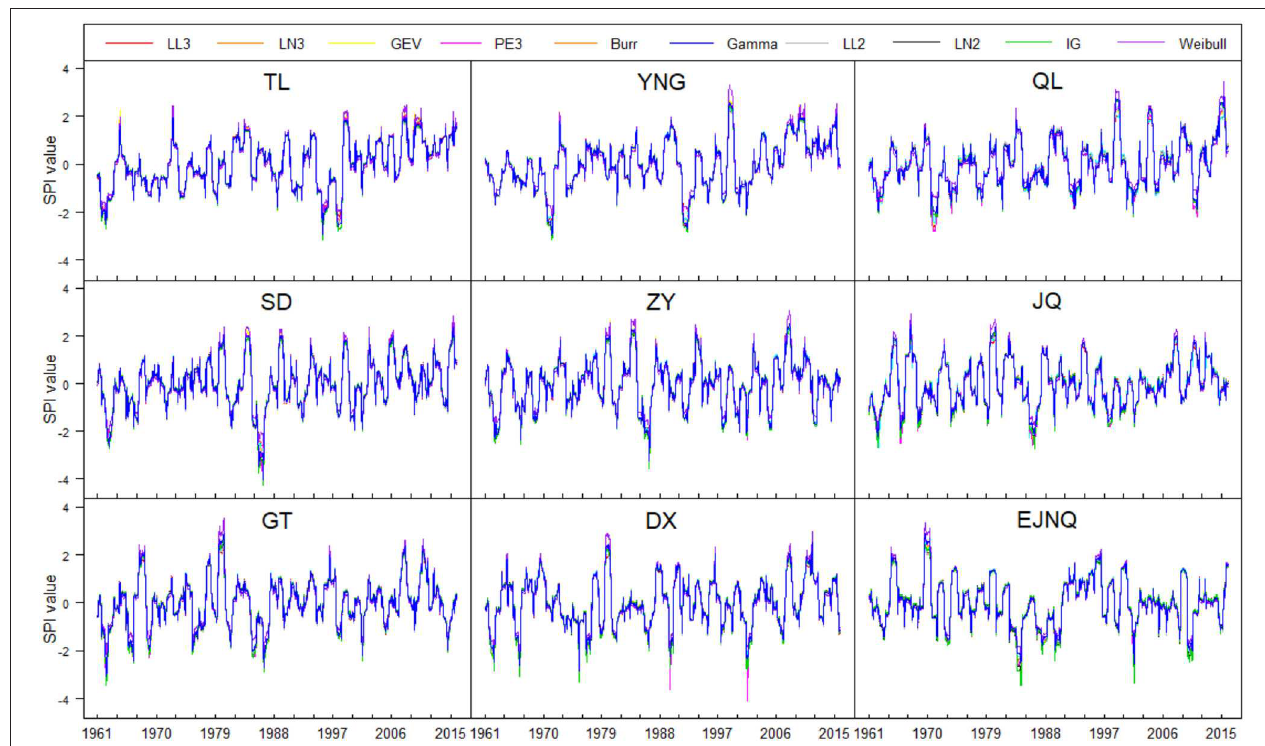
FIGURE 3 | SPI values modeled by different probability distributions (LL3, LL2, LN3, LN2, GEV, PE3, and IG represent the three- and two-parameter log-logistic and log-normal, generalized extreme value, Pearson-III, and inverse Gaussian distributions, respectively; TL, YNG, QL, SD, ZY, JQ, GT, DX, and EJNQ are Tuole, Yeniugou, Qilian, Sandan, Zhangye, Jiuquan, Gaotai, Dingxin, and Ejinaqi stations, respectively).